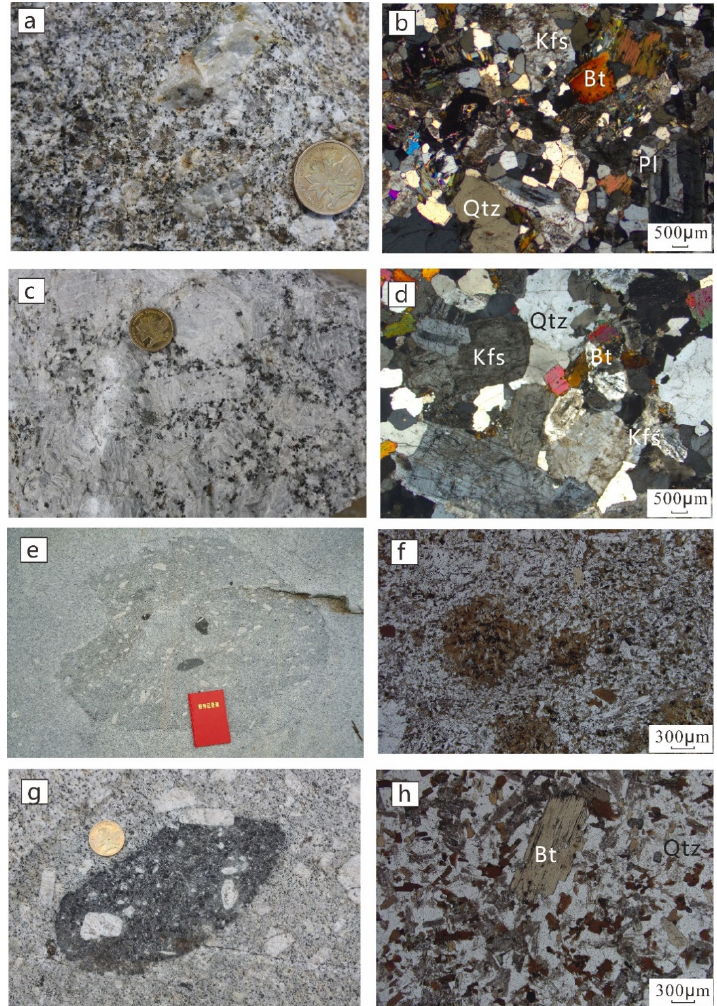
Figure 3. Field photographs and microscope images of rocks and microgranular enclaves (MEs) of the Xitian intrusion. ( a , b ) Biotite monzogranite; ( c , d ) Bitotie granite; ( e ) Field photograph showing MEs in the granite of the Xitian intrusion; ( f ) Biotite agglomerates; ( g ) The feldspar crystal passes through MEs; ( h ) MEs. Abbreviations: Qtz (quartz); Kfs (K-feldspar); Pl (plagioclase); Bt